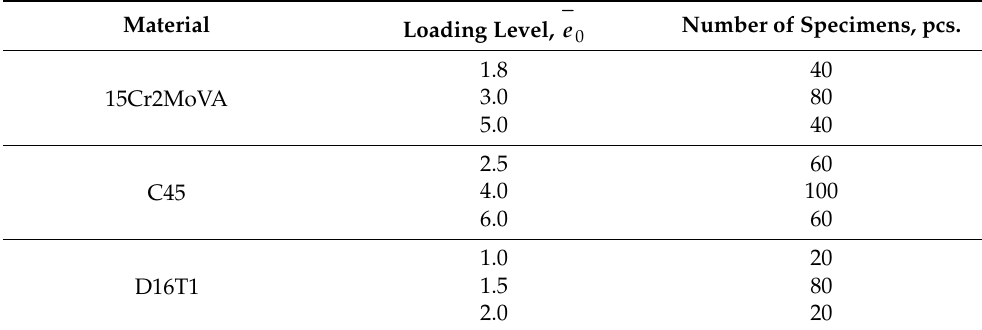
Table 3. Low cycle testing programme under strain-controlled loading ( e 0 =